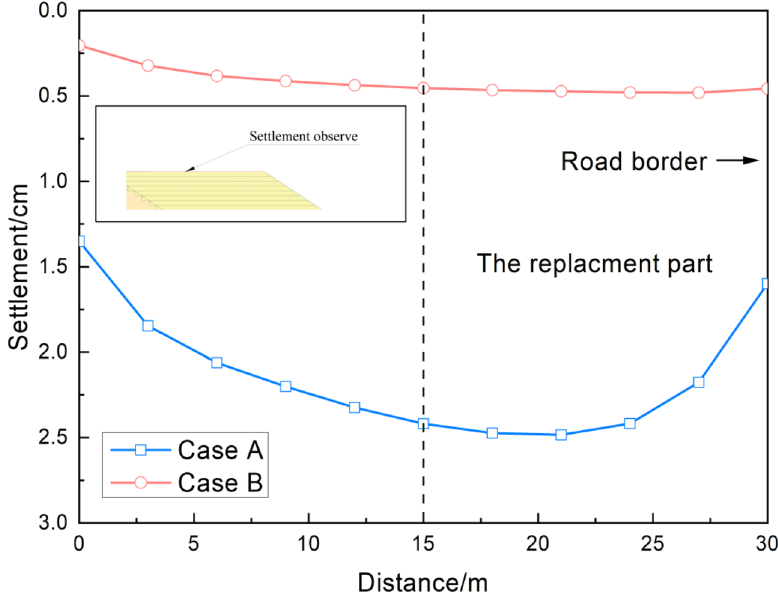
Figure 6. Final settlement of the embankment surface.